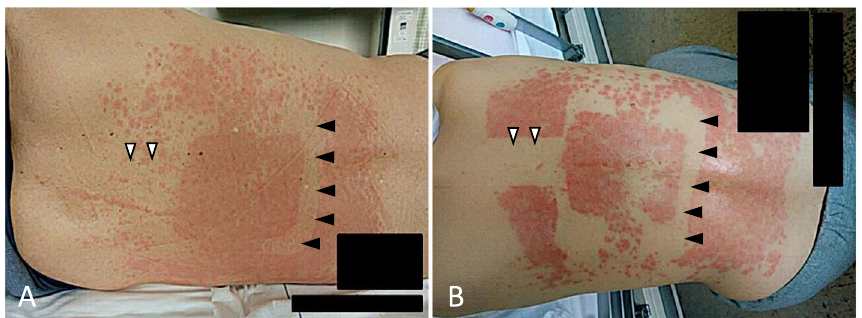
Fig. 2 Erythematous papules on the back after disinfection with Olanedine Antiseptic Solution 1.5% (Olanedine ® ). A and B show erythematous papules observed in the area disinfected with Olanedine ® in cases 1 and 2, respectively. An erythematous papule rash was not observed in the area where the surgical drape was taped (black arrowheads) or the area where the patient’s back was taped to secure an epidural catheter (white arrowheads) in either